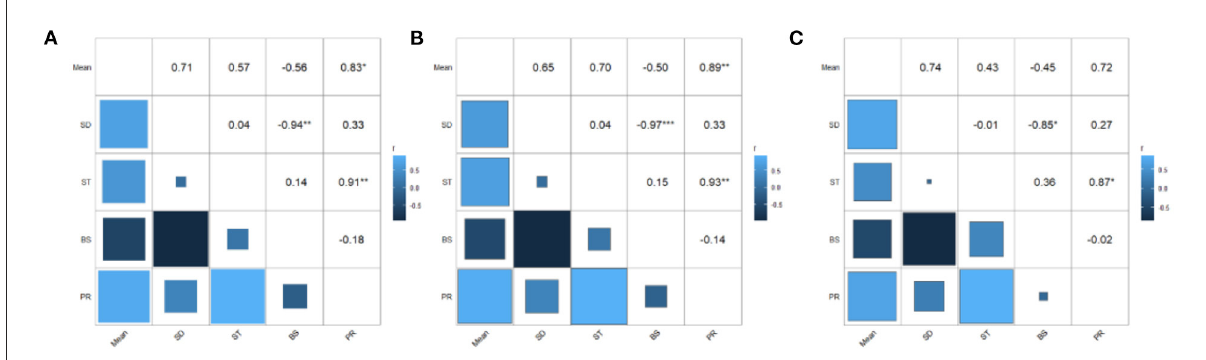
FIGURE2 The matrix of correlations between mean value, standard deviation, strength, bridge strength, and predictability. (A) Elderly adults. (B) Male elderly. (C) Female elderly.